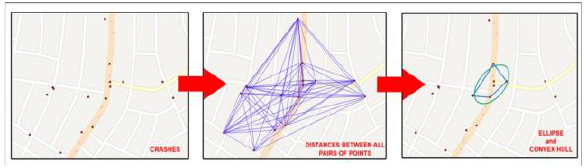
Figure 2. NNH clustering algorithm (Kundakci and Tuydes- Yaman,